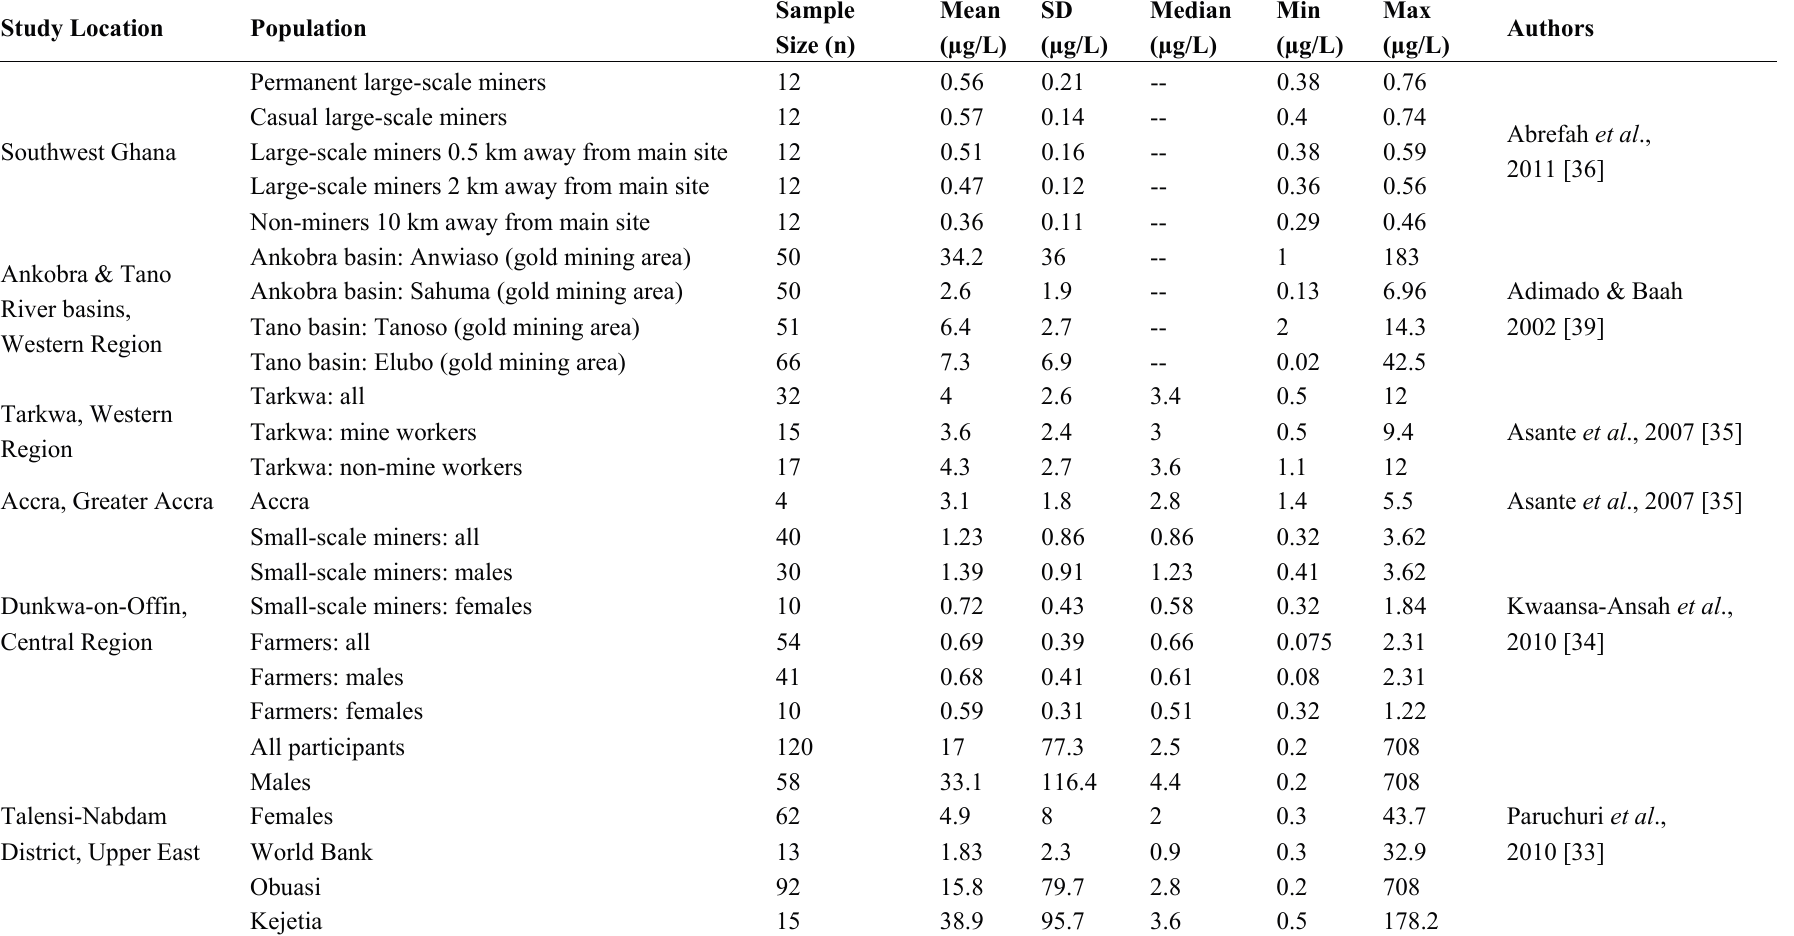
Table A1. A summary of mercury concentrations in human urine samples from ASGM miners and non-miners from across Ghana. Study